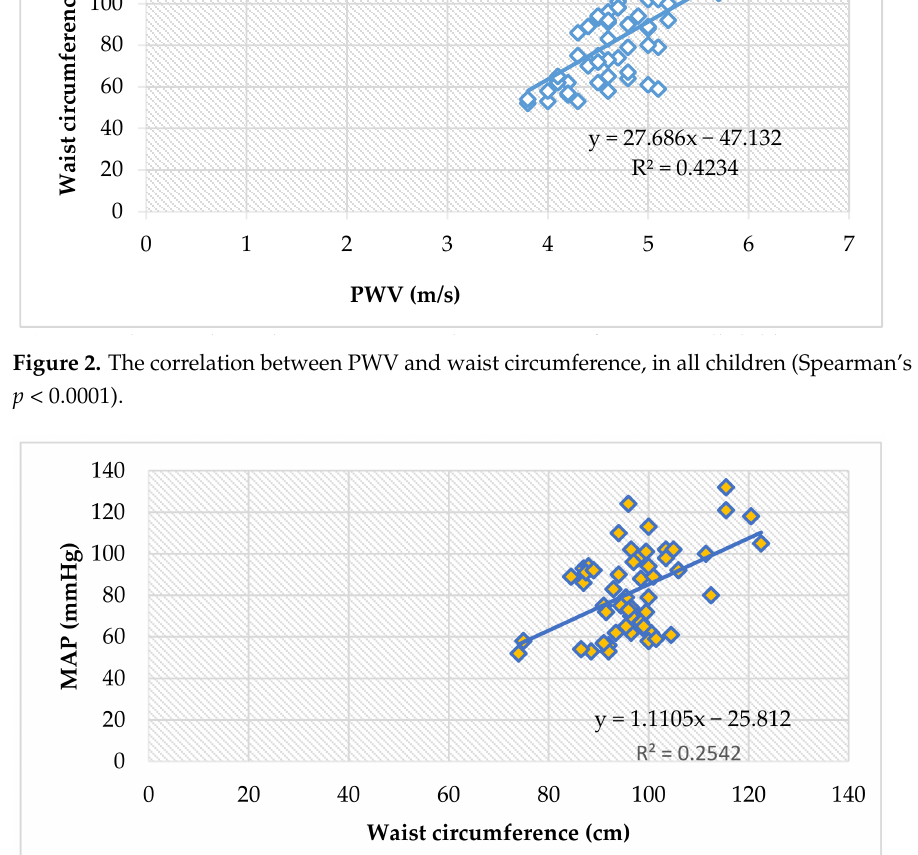
y = 27.686x − 47.132 R² = 0.4234